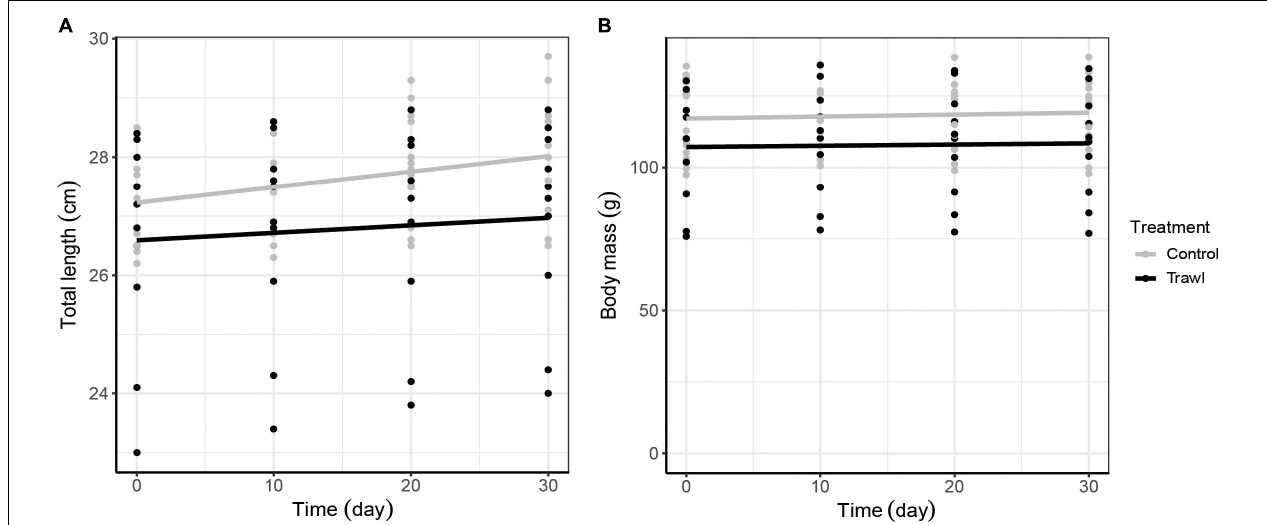
FIGURE 4 | Neonate total length (cm; A ) and body mass (g; B ) growth increment with time. Total length and body mass data are plotted against time separately for each maternal Treatment: Control (gray; n = 16) and Trawl (black; n = 11). Points represent original data, and the lines were fitted by linear regression. Note that in (A) , the y axis starts from 23